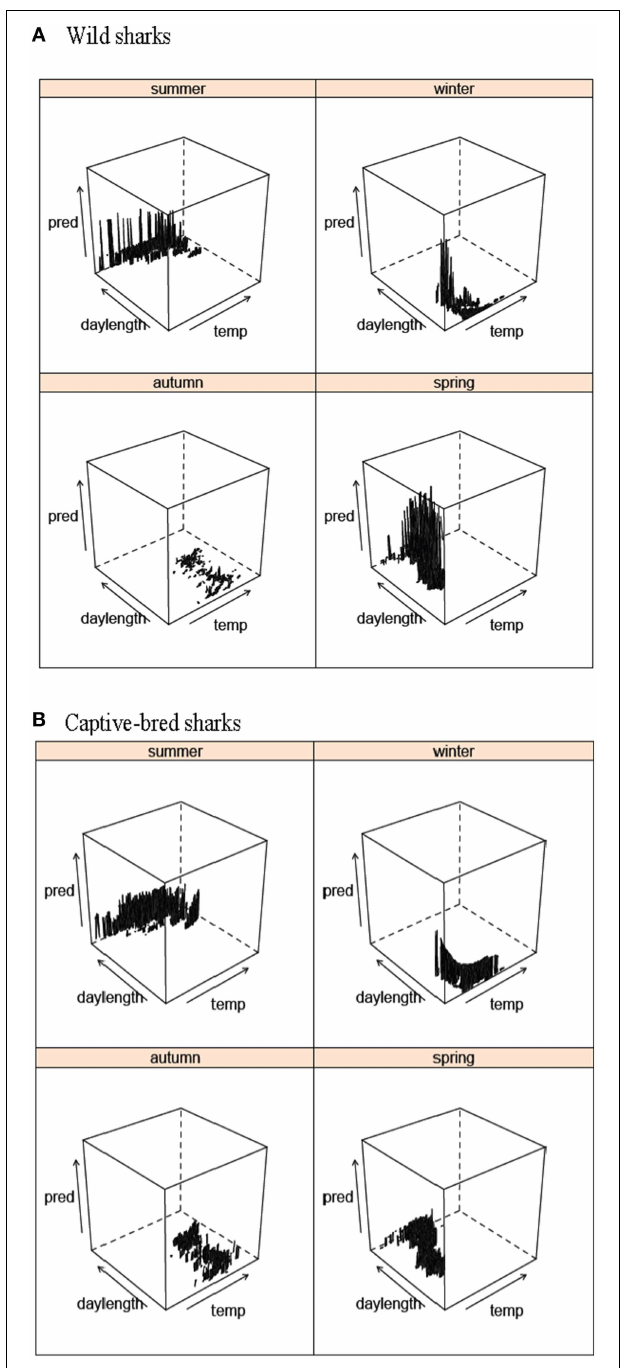
FIGURE 6 | Predicted values from the best GLMM models for the probability of (A) wild and (B) captive-bred wobbegongs being present at CTBAR against austral season depending on water temperature and day length.